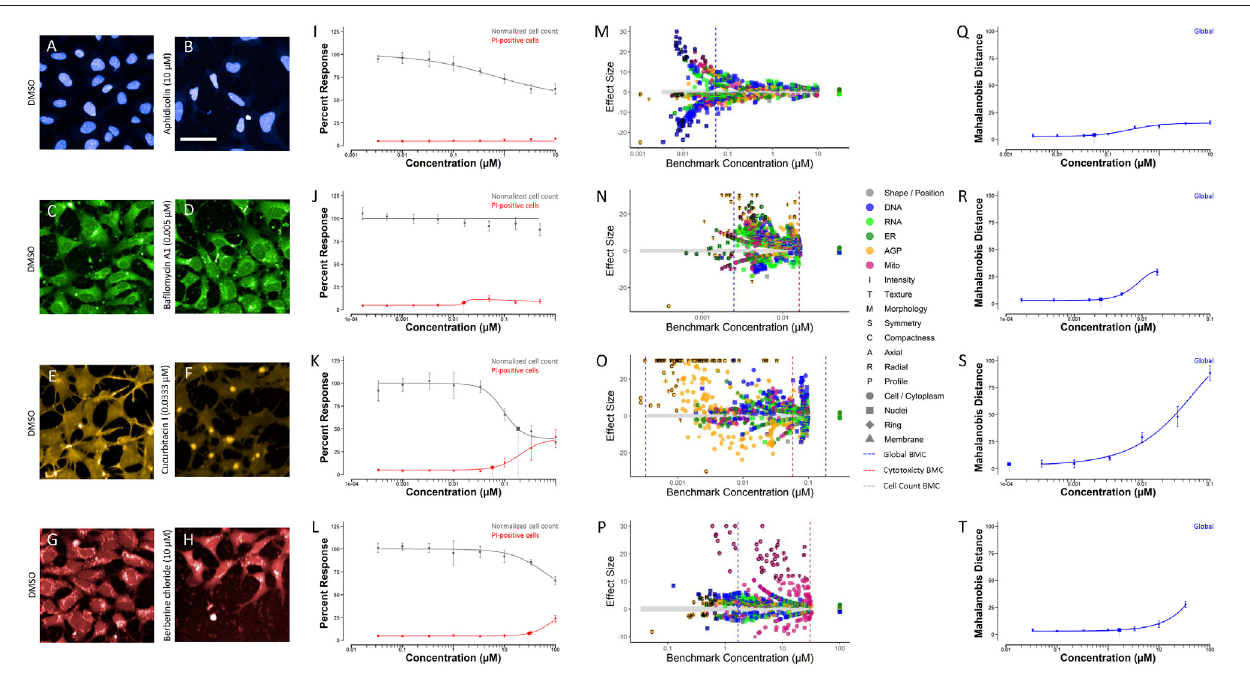
FIGURE7| Selectedreferencechemicals. Images were captured witha20X water immersion objective. Harmony ® software wasused toprocess the images and Microsoft PowerPoint to crop and enlarge distinct areas. A representative image of DMSO vehicle control compared to aphidicolin (A,B) , ba fi lomycin A1 (C,D) , cucurbitacin I (E,F) , and berberine chloride (G,H) is displayed. Cell-level data were exported to generate cell viability (I – L) , feature-level potency-magnitude (M – P) , and global (Q – T) concentration-response curves in R statistical software. Data represent three biological replicates (i.e., independent cultures) which includes two technicalreplicates/chemical concentration per biologicalreplicate. Theenlargedsymbols onthecellviabilityandglobal concentration-response curves depicttheBMC for each endpoint, whereas the dotted-lines on the feature-level potency-magnitude plots depict the global (blue), cytotoxicity (red), and normalized cell count (gray) BMC, respectively. The gray band on the feature-level potency-magnitude plots represents the concentration-range modeled (i.e., all concentrations ≤ LOEC) in the horizontal direction and ±1 standard deviation from the median of the DMSO vehicle control in the vertical direction. Chemicals: aphidicolin [ (B) : 10 μ M; I: CV; (M) : feature-level; (Q) : global]; ba fi lomycin A1 [ (D) : 0.005 µM; (J) : CV; (N) : feature-level; (R) : global]; cucurbitacin I [ (F) : 0.0333 µM, (K) : CV; (O) : feature-level; (S) : global]; berberine chloride [ (H) : 10 μ M; (L) : CV; (P) : feature-level; (T) : global]; DMSO (A,C,E,G) . Scale bar = 20